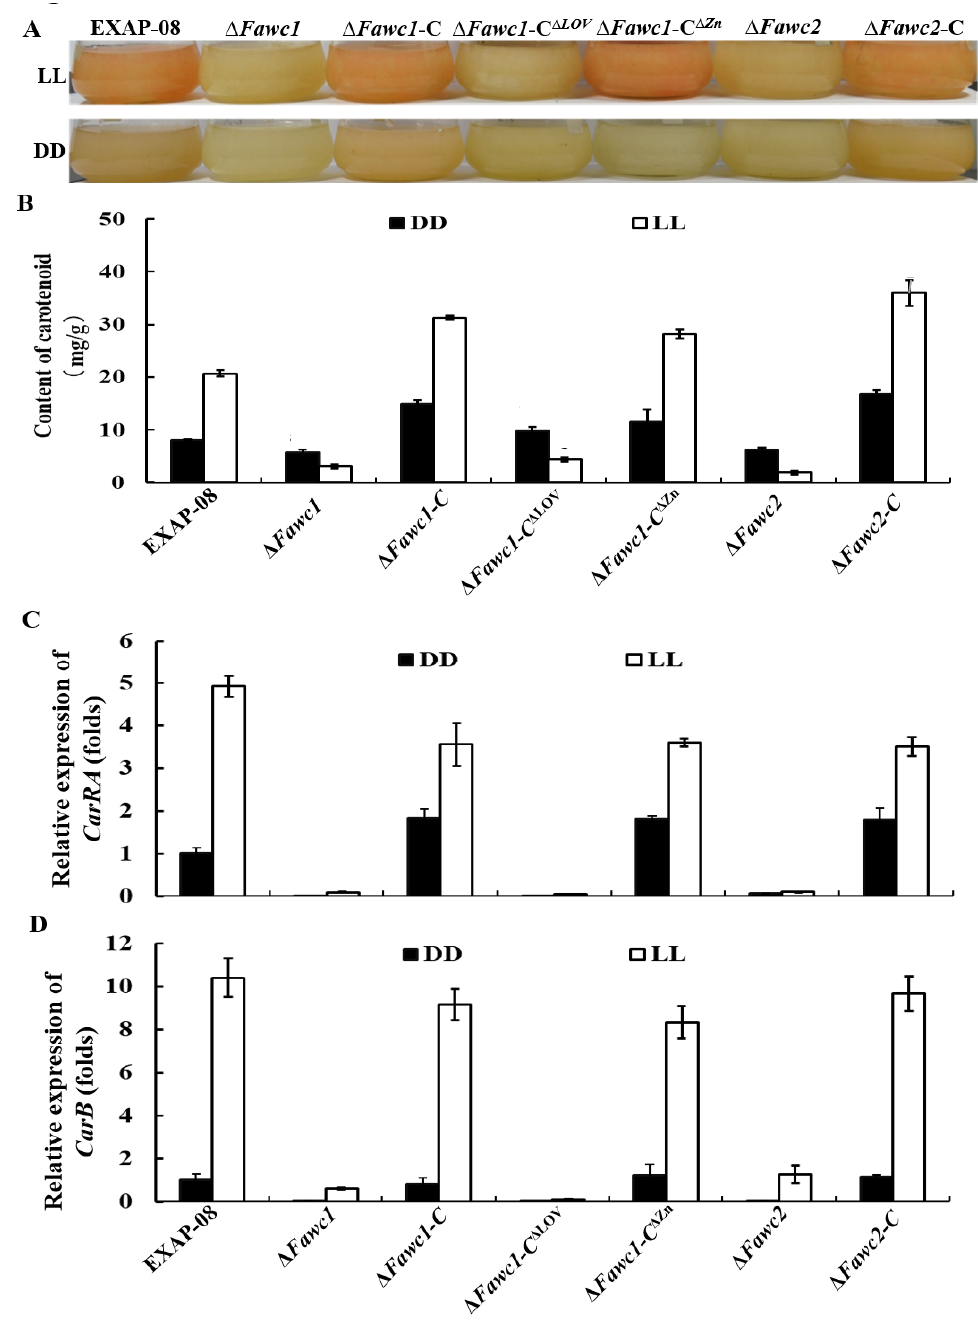
Figure 4. Effect of light on carotenogenesis. ( A ). Carotenoid pigment accumulation of the tested strains cultured in liquid CM for four days under constant light (LL) or darkness (DD). ( B ). Measurement of carotenoid contents in the mycelium of each strain harvested from the liquid shaking culture in ( A ). ( C ) and ( D ). Relative expression levels of deduced carotenoid biosynthesis genes CarRA and CarB in wild-type and mutant strains under light (LL) or darkness (DD). The bars in B , C , and D present mean values ± SD of three replicate samples.